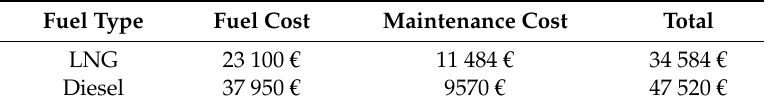
Table 2. Annual fuel and maintenance costs comparison for diesel and LNG